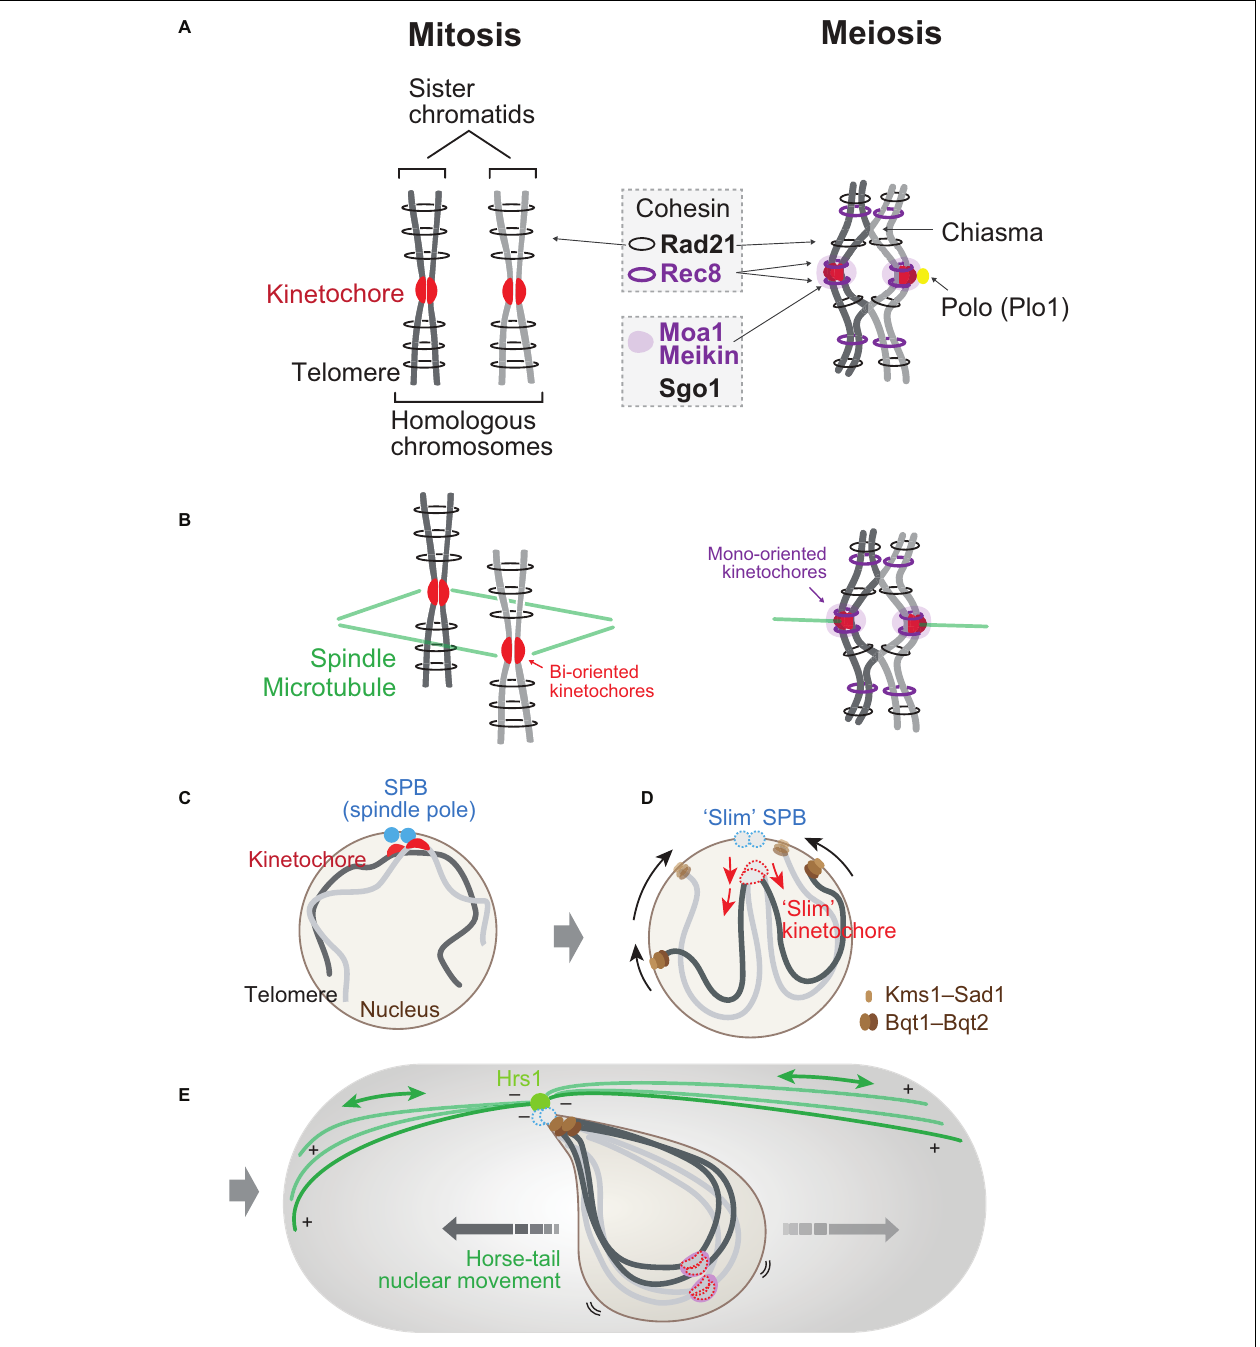
FIGURE 1 | Chromosomes in mitosis and in meiosis. (A) Chromosomes in mitosis and in meiosis. During mitotic cell cycles (left), homologous chromosomes behave independently. Sister chromatids are connected by mitotic cohesin Rad21 (Scc1). In meiosis I (right), homologous chromosomes are paired and crossed via chiasmata. Rad21 locates in the arm region of chromosomes in both divisions, whereas meiotic cohesin Rec8 (purple ring) locates in both the arm and centromeric regions. Moa1 (Meikin) is a meiosis-specific kinetochore protein that protects centromeric Rec8 cohesin through the recruitment of shugoshin (Sgo1) to centromeres and regulates attachment to microtubules through the recruitment of Polo kinase (Plo1). (B) Orientation of kinetochores. In mitosis (left), sister kinetochores are bi-oriented in a back-to-back position. In meiosis I, sister kinetochores are oriented in a side-by-side position. Spindle microtubules, green. (C–E) Conversion of chromosome arrangement upon sexual differentiation in fission yeast. In interphase (e.g., G1 phase) of mitotic cycles (C) , centromeres (kinetochores; red) are clustered at spindle pole bodies (SPBs; blue). In reaction to mating pheromone (D) , telomeres get clustered to SPBs. Telomeres slide on the nuclear envelope toward SPBs via interaction with meiosis-specific bouquet proteins (Bqt1 and Bqt2) and nuclear membrane proteins (Kms1/2–Sad1). Kinetochores are dissociated off SPBs. A number of kinetochore and SPB components are dissociated in this stage (slim SPBs and kinetochores). During meiotic prophase (E) , a cytoplasmic array of microtubules is tethered by Hrs1 at SPBs, thereby shaking the nucleus. The SPB-led back-and-forth movement of the nucleus is called horse-tail nuclear movement.